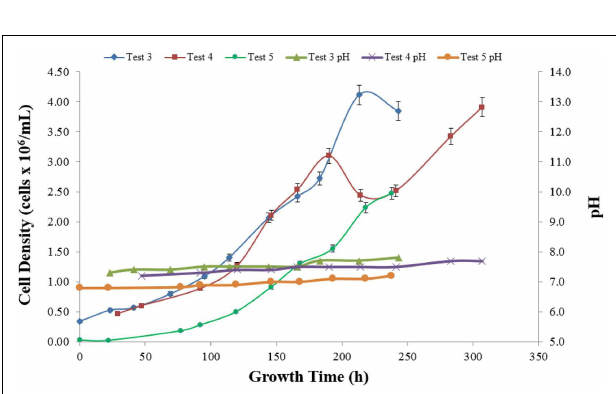
FIGURE 8 |Three productivity tests in the bioreactor using Bristol media .